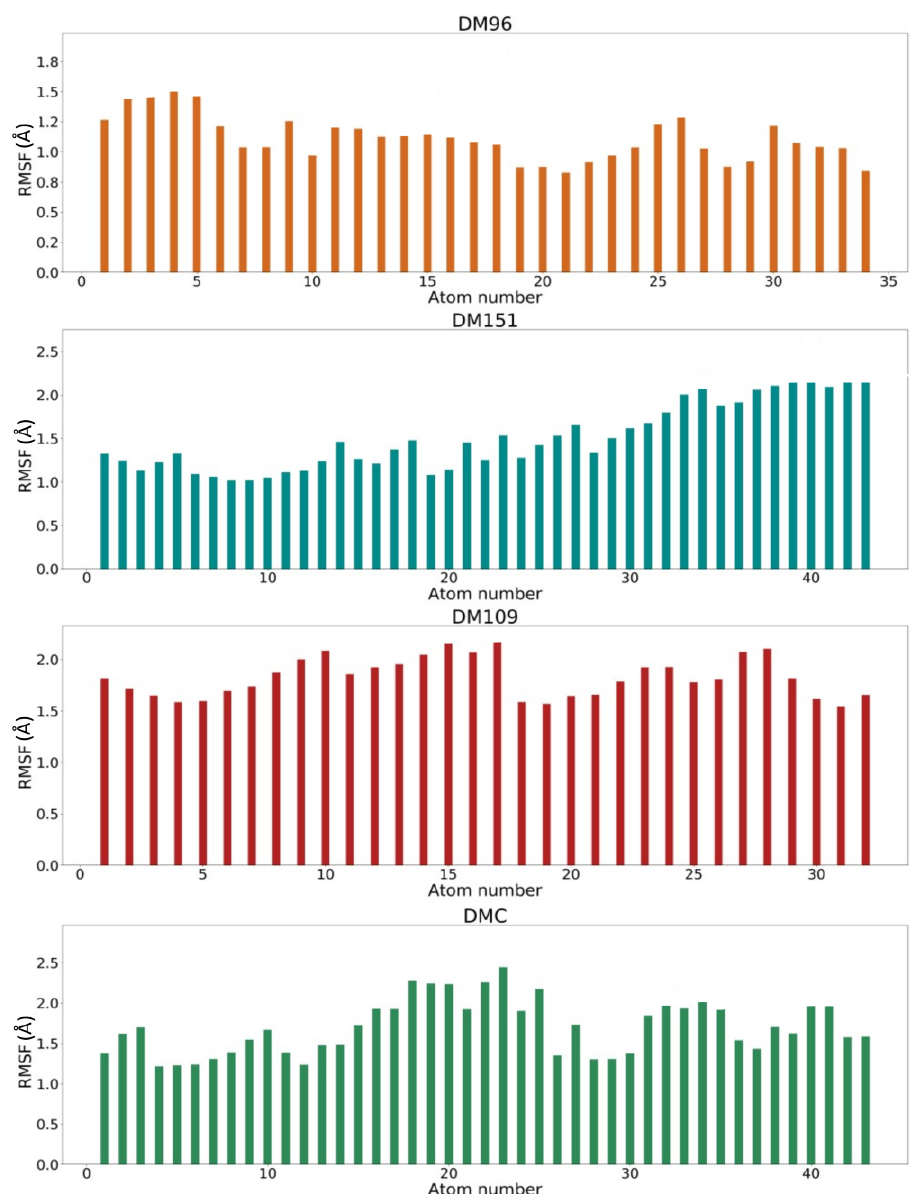
Figure 7. RMSF values of ligand atomic positions throughout molecular dynamics simulation pro- duction runs of hGSTP1-1 /DM96 (red), hGSTP1-1/DM151 (orange), hGSTP1-1/DM109 (green), and hGSTP1-1/DMC (blue) complexes. Table 5. Average RMSD values of ligand and backbone atomic positions together with average RMSF values of ligand and backbone atomic positions throughout four independent 20 ns molecular dynamics simulation production runs of hGSTP1-1/DM96, hGSTP1-1/DM151,